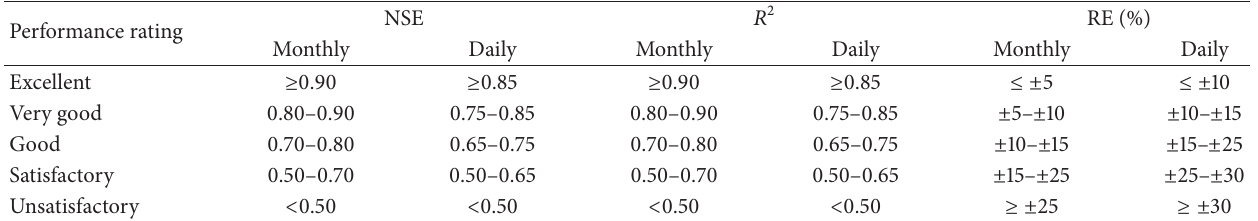
Table 3: General performance ratings for three evaluation criteria.